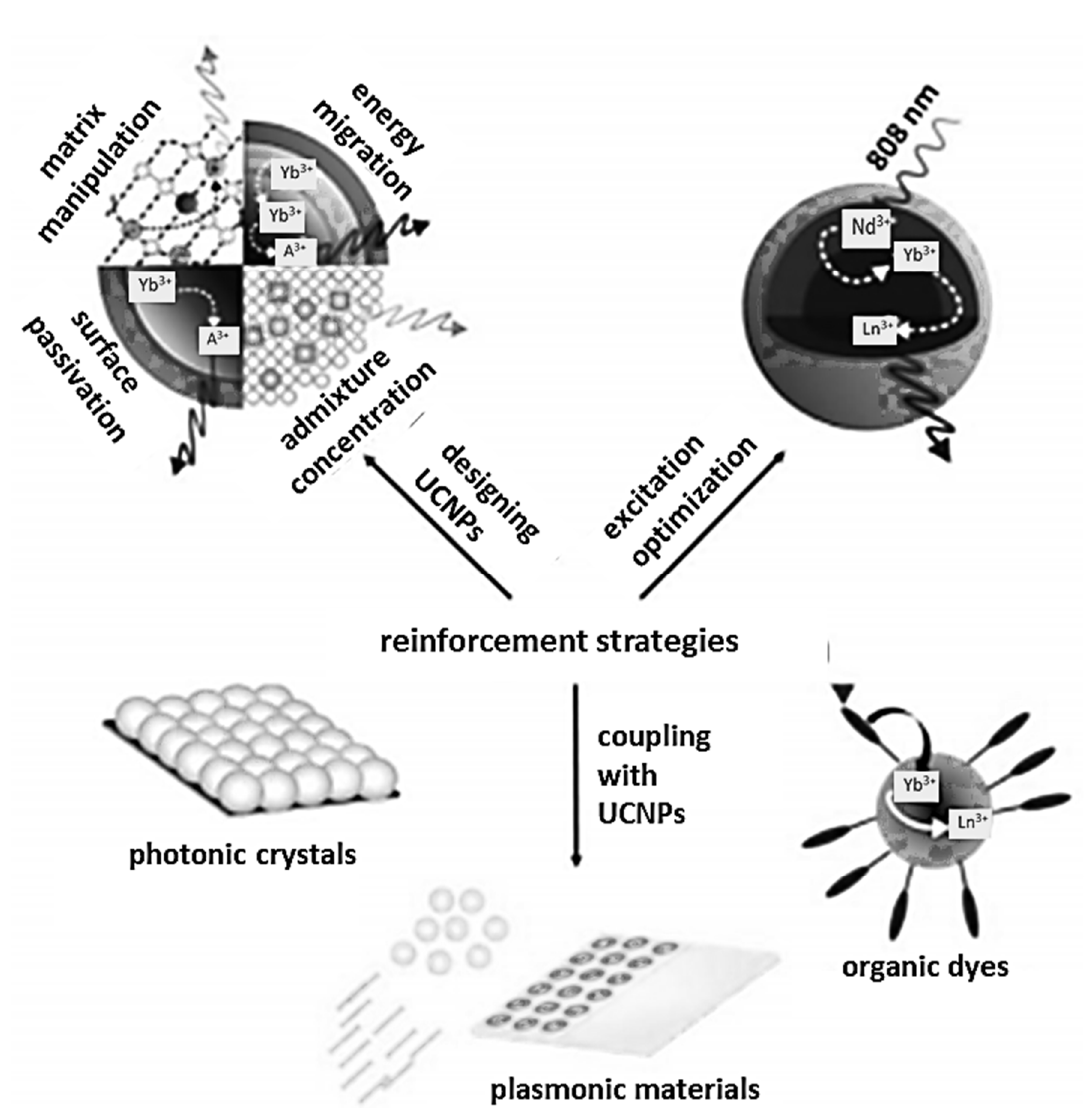
Figure 5. Upconversion enhancement strategy.